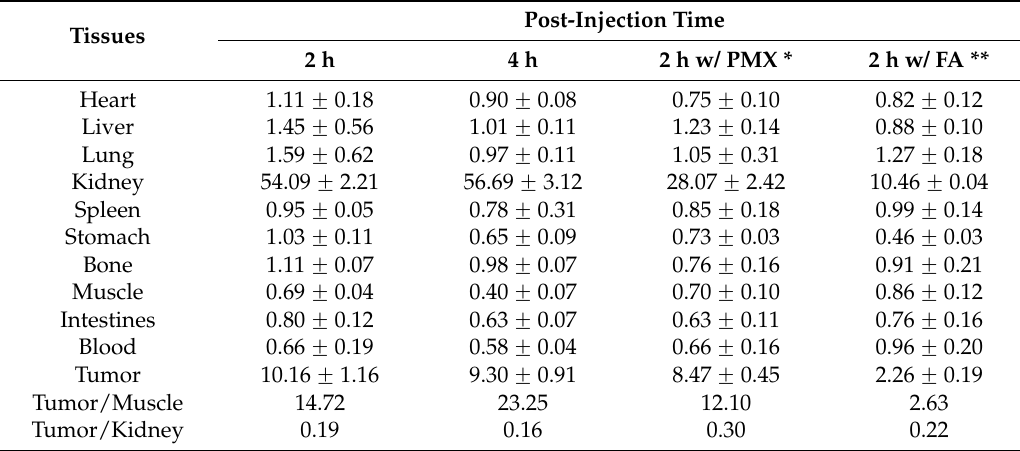
Table 2. The biodistribution results of 99m Tc-HYNIC-D 1 -FA 2 in KB tumor-bearing mice (%ID/g, mean ± SD, n = 5).